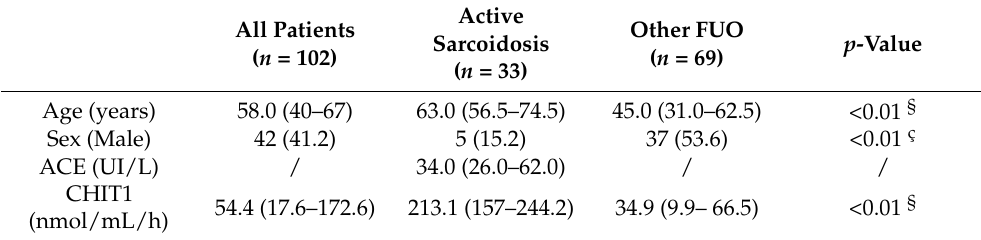
Table 4. Demographic data and biomarker values in the active sarcoidosis group compared to the other FUO group. Continuous variables are presented as mean ± standard deviation; categorical data are presented as absolute number (%). § t-test for unpaired data; ç chi-square test.